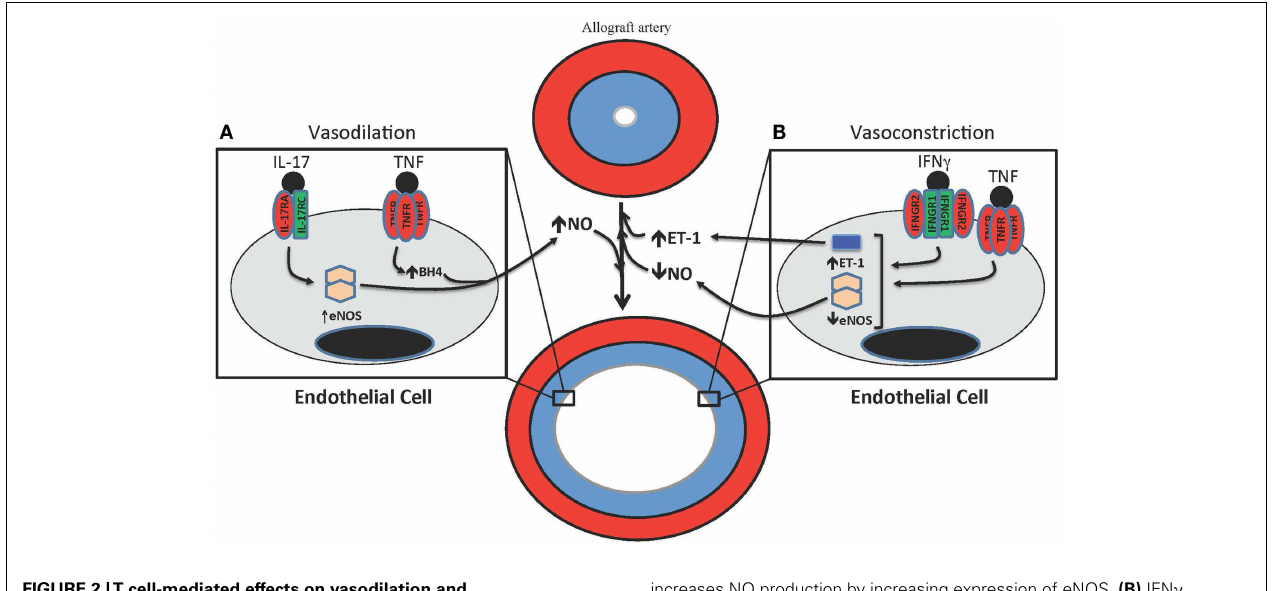
FIGURE 2 |T cell-mediated effects on vasodilation and vasoconstriction in allograft arteries . (A) TNF and IL-17 are produced byT cells in allograft arteries.TNF acutely increases NO production from the endothelium by increasing eNOS activity through the up-regulation of tetrahydrobiopterin (BH 4 ) synthesis. IL-17